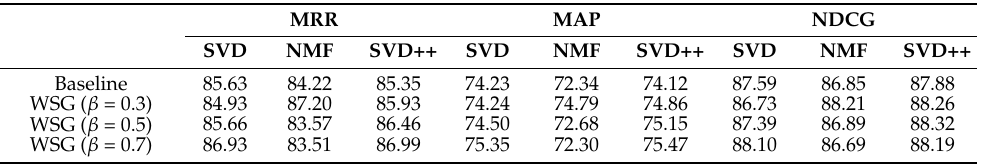
Table 1. MRR, MAP, and NDCG values (%) without and with L-CNN sentiment and genres-based model on the MARD dataset with different β